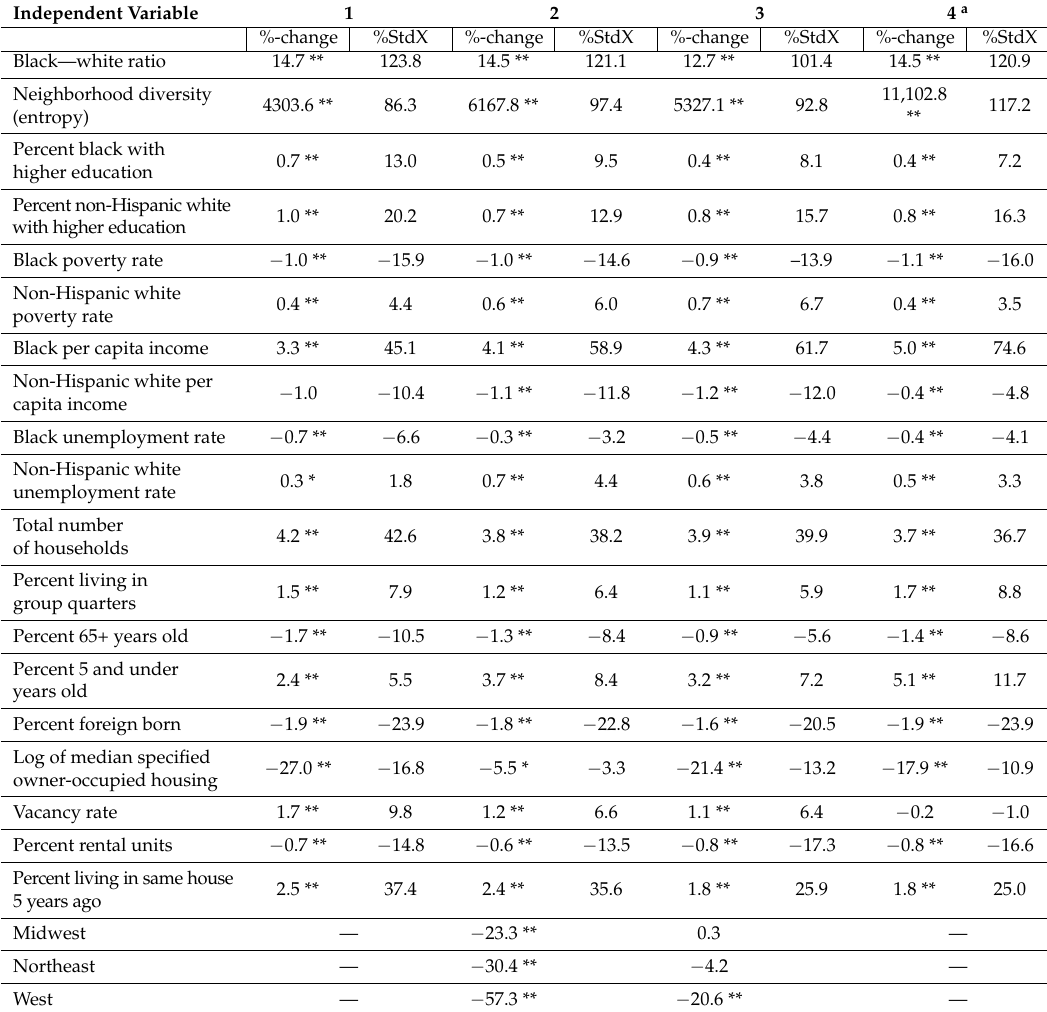
Table 2. Percentage change in affluent black households calculated from negative binomial regressions of number of affluent black households per neighborhood,